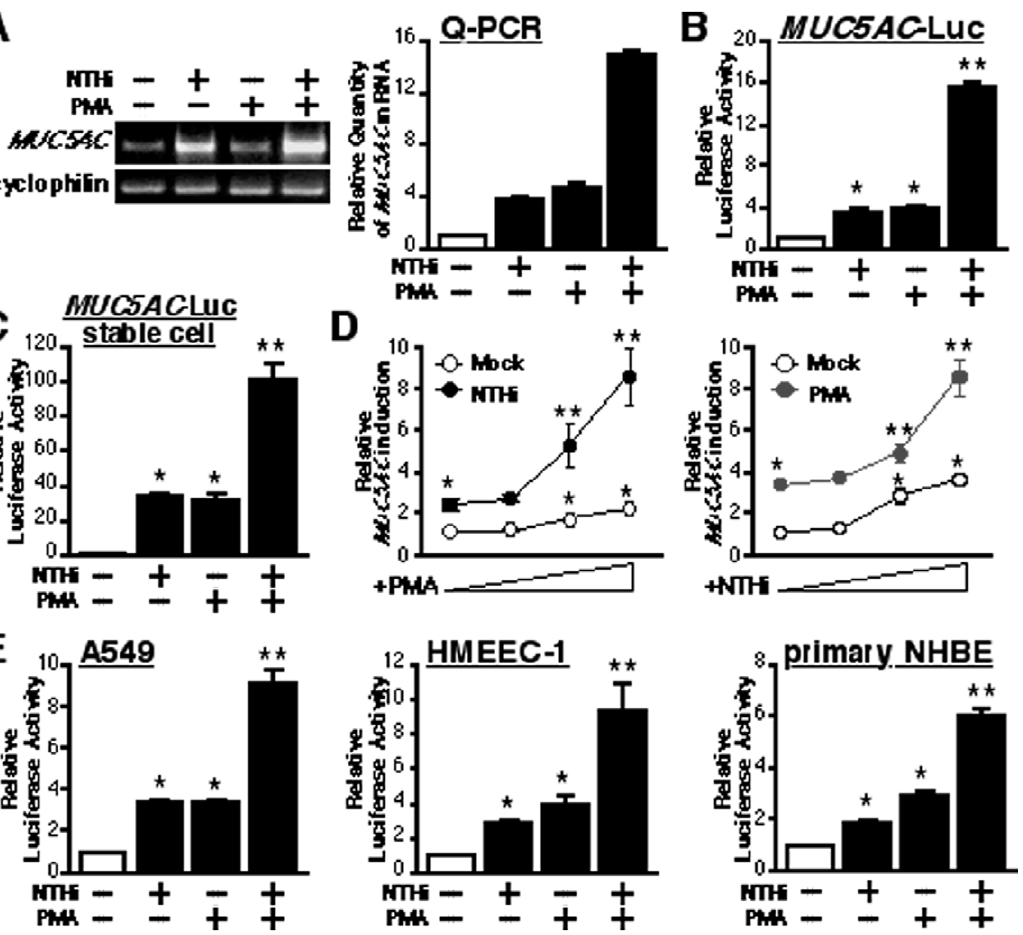
Figure 1. PMA synergizes with NTHi to induce MUC5AC expression in human epithelial cell. ( A ) PMA synergistically enhanced NTHi- induced MUC5AC expression at the mRNA level in human epithelial HM3 cell, as assessed by performing RT-PCR (left panel) and real-time quantitative PCR (Q-PCR) analysis (right panel). Cyclophilin was used as a control for amount of RNA used in each reaction. ( B ) PMA synergized with NTHi to induce MUC5AC expression at the transcriptional level in human epithelial cells, as assessed by MUC5AC-dependent promoter Luciferase assay. ( C ) Synergistic induction of MUC5AC expression by NTHi and PMA was also observed in HM3 cells stably transfected with pMUC5AC 3.7 kb-luc. ( D ) PMA synergizes with NTHi to induce MUC5AC transcription in a dose-dependent manner and vice versa. ( E ) PMA synergistically enhanced NTHi-induced MUC5AC expression at the transcriptional level in human airway A549, middle ear HMEEC-1 and primary bronchial epithelial NHBE cells, as assessed by MUC5AC-dependent promoter assays. Values are the means 6 S.D. (n=3). *p , 0.05 vs. control; **p , 0.05 vs. NTHi alone. The data shown are representative of three independent experiments. 2 , absence of; + , presence of; NTHi, nontypeable Haemophilus influenzae .